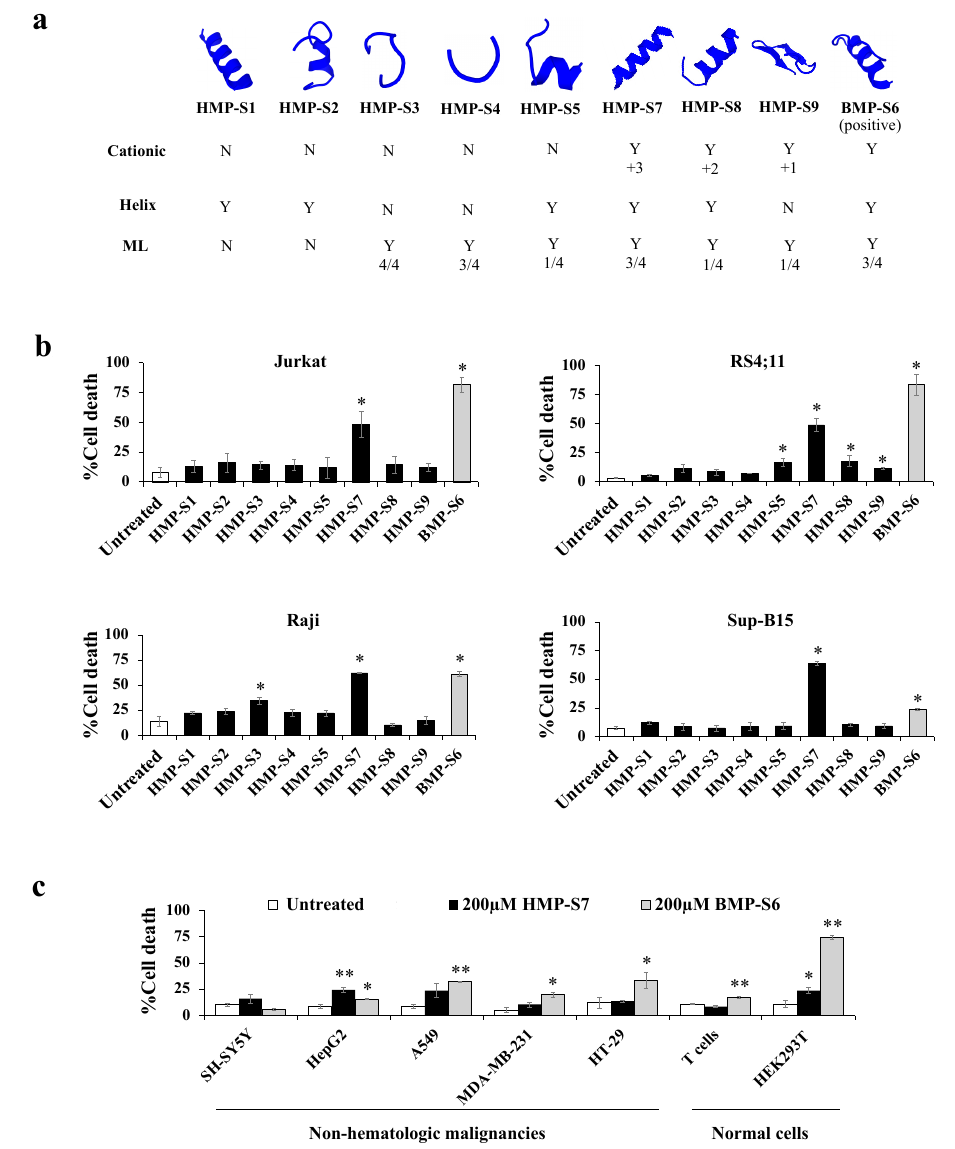
Figure 4. Effect of the 8 synthetic human milk peptides (HMPs) on leukemic and nonleukemic cell lines. ( a ) Eight HMPs and a positive control (BMP-S6) were selected and synthesized to test for antileukemic activity. The properties of these peptides are summarized, namely predicted secondary structure, cationic nature, helix content, machine learning (ML) prediction of ACP (details of the selected peptides are summarized in Table S3); ( b ) four leukemic cell lines, namely Jurkat, Raji, RS4;11, and Sup-B15, were treated with the 8 synthetic HMPs and the control BMP-S6 at 200 µM, and % cell death was observed after 24 h treatment using the trypan blue exclusion assay under a light microscope. The % cell death was calculated as: number of death cells/total cell number × 100%. The percentages of cell death of all 4 leukemic cell lines after HMP-S7 treatment were significantly increased; ( c ) in addition to leukemic cells, HMP-S7 was also tested on nonhematological malignant cell lines, including neuroblastoma (SH-SY5Y), hepatoblastoma (HepG2), lung cancer (A549), triple- negative breast cancer (MDA-MB-231), colon cancer (HT-29), as well as on normal cells, such as T cells and HEK293T embryonic kidney cells. Statistical significance of differences in % cell death was calculated using three biological replicates. * p < 0.05, ** p < 0.01 compared to untreated cells.